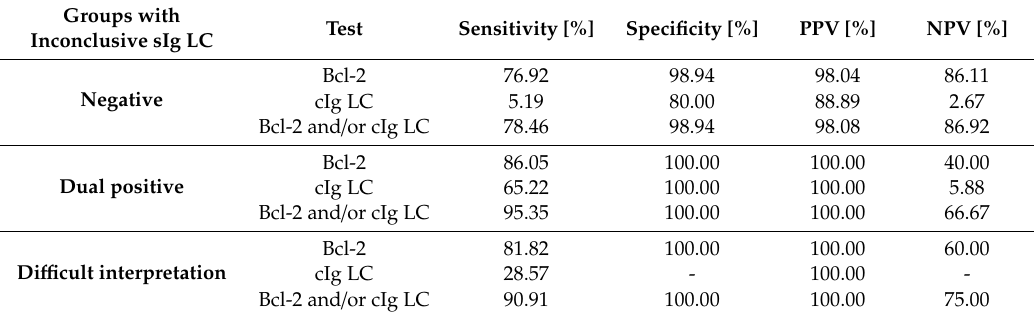
Table 3. Sensitivity, specificity, PPV and NPV of the Bcl-2 test (qualitative and quantitative), of the cIg LC test and of the two tests together in groups with inconclusive sIg